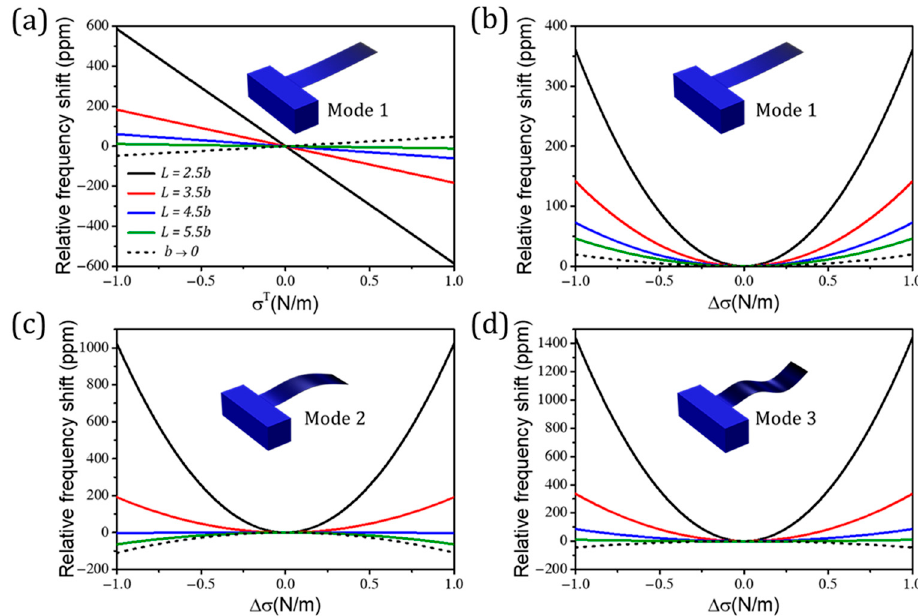
Figure 3. ( a ) Theoretical prediction of the relative frequency shift due to net surface stress σ T for the fundamental mode of a silicon nitride cantilever of 100 nm in thickness and 20 µm in length for different values of the width. ( b–d ) The theoretical prediction of the relative frequency shift due to the differential surface stress ∆ σ for the same cantilever and for the first, second, and third flexural modes, respectively, as well as for different values of the width. Insets show a representation of the mode shape.